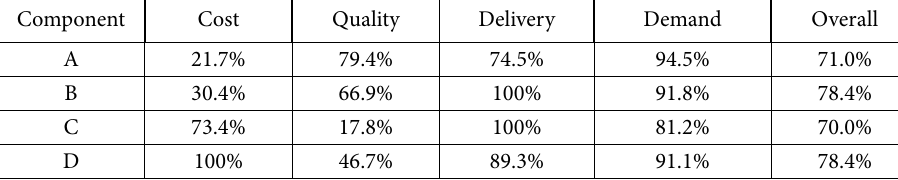
Table 20. Achievement levels for objectives and demand constraint